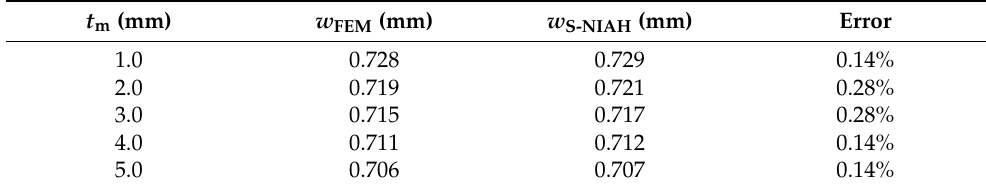
Table 4. Deflections and errors at mid-point under different t m .